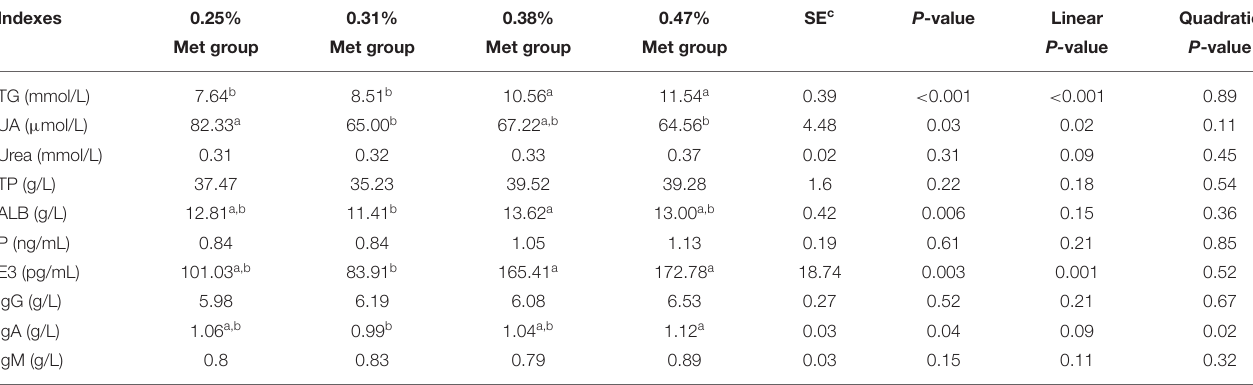
TABLE 3 | The effects of different dietary Met supplementation in low protein diets on the serum parameters of laying hens that are 38–50 weeks. Indexes 0.25% 0.31% 0.38% 0.47% SE c P -value Linear Quadratic Met group Met group Met group Met group P- value P -value